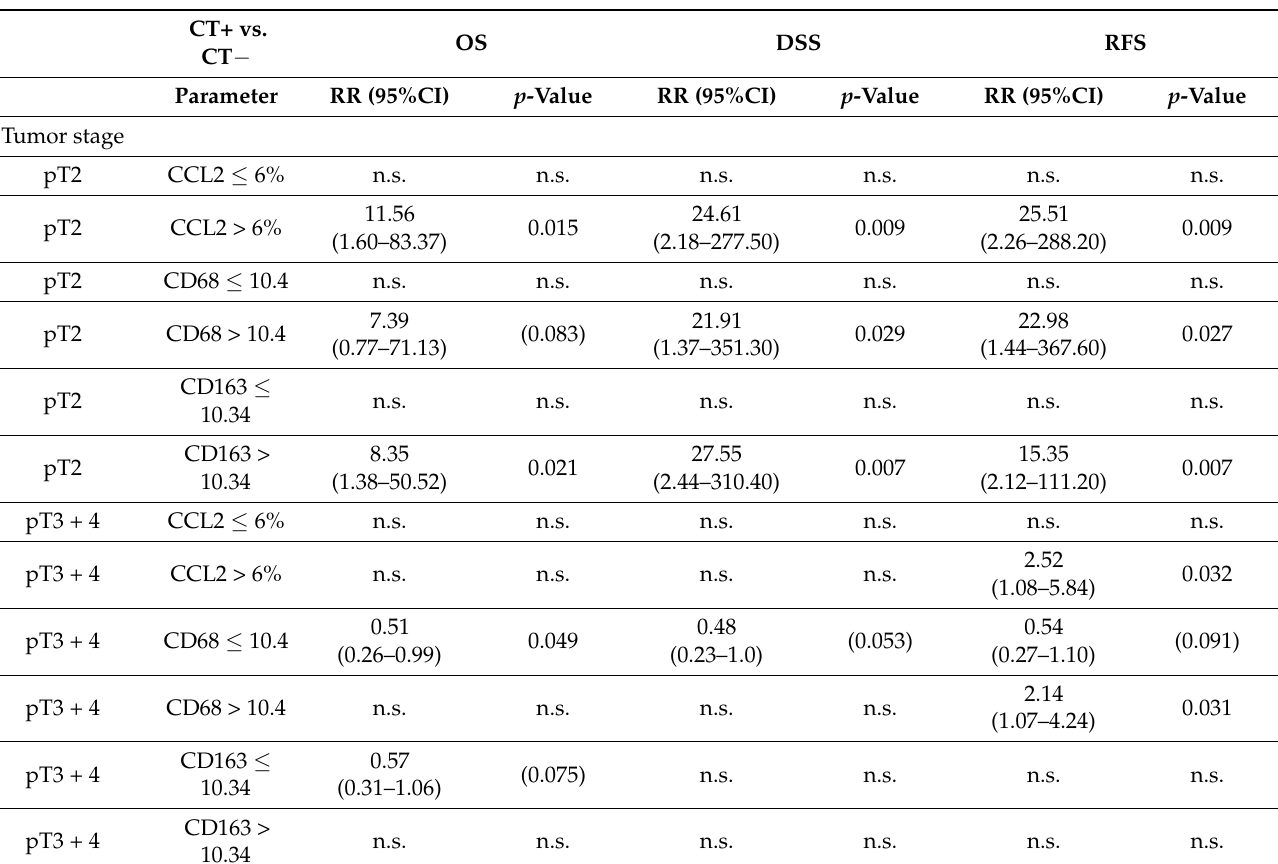
Table 3. Univariate Cox’s regression analysis: Association between chemotherapy, considering the immune markers CCL2, CD68, and CD163, and prognosis stratified by the tumor stage. CT+